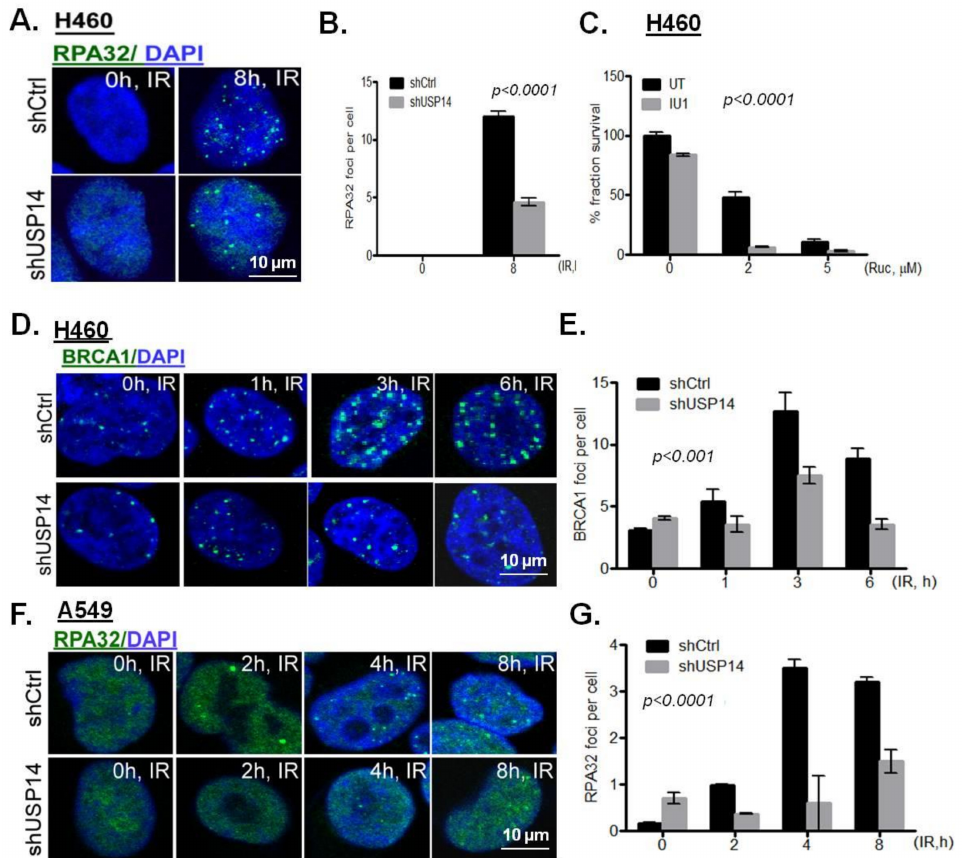
Figure 5. Targeting USP14 inhibits homologous recombination. ( A , B ) Confocal immunostaining and graphical representation of RPA32 IRIFs in shControl (shCtrl)- vs. shUSP14-expressing H460 cells at 8 h following 5 Gy IR treatment. Nuclei were stained with DAPI. ( C ) Clonogenic survival analysis in H460 cells pretreated with 50 µ M IU1 for 1 h +/ − indicated doses of rucaparib (Ruc). Confocal immunostaining and graphical representation of IRIFs for ( D , E ) BRCA1 in H460 and ( F , G ) RPA32 in A549 cells at the indicated time points in shControl (shCtrl)- vs. shUSP14-expressing cells. Nuclei were stained with DAPI. Data shown are the means ± SEM ( n =